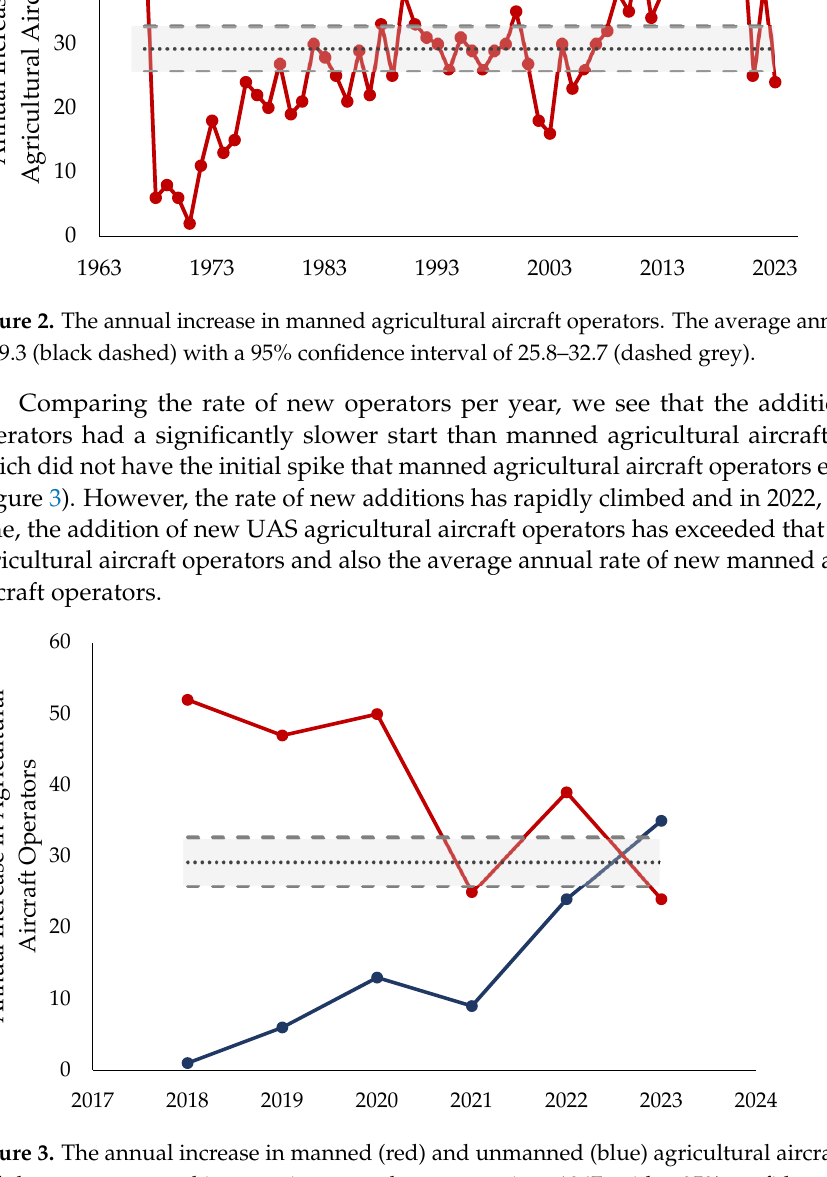
Figure 1. The total number of manned ( A , red) and unmanned ( B , blue) agricultural aircraft operators in the United States.